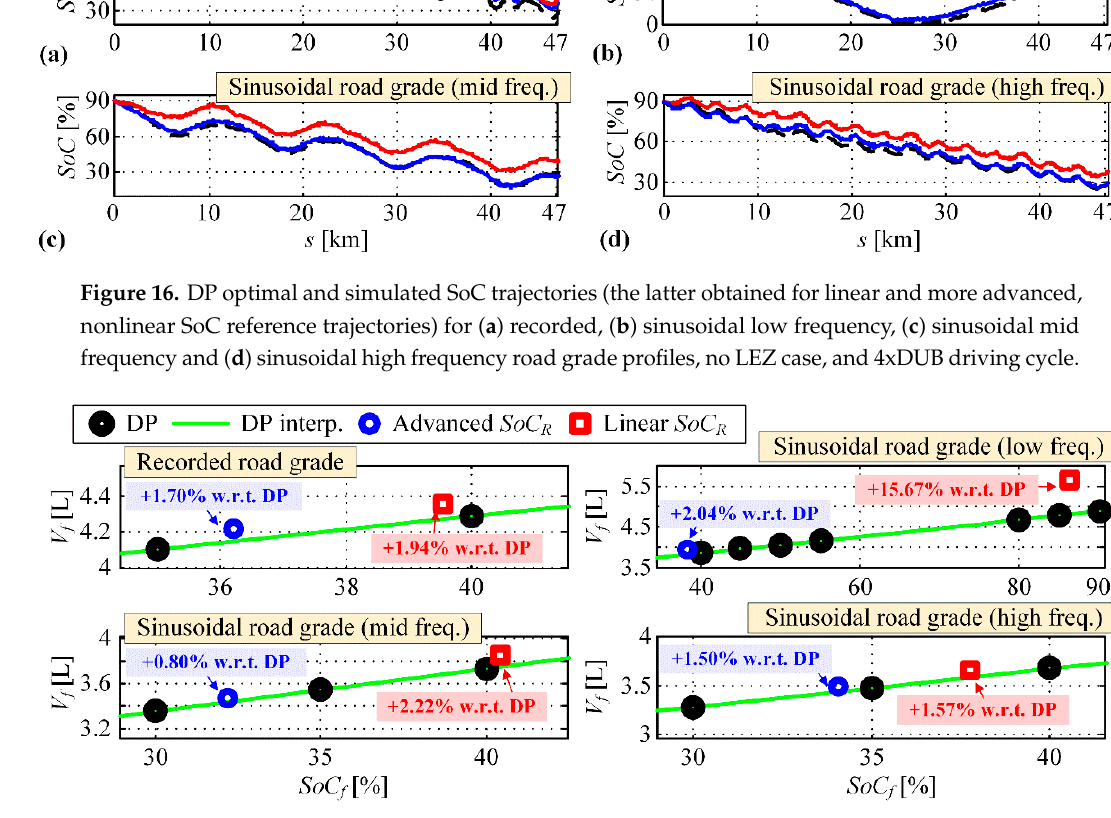
Figure 17 . Fuel consumption values corresponding to simulation results from Figure 16.